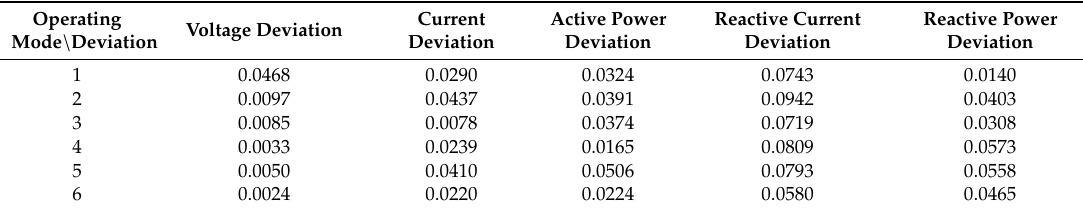
Table 5. Weighted mean deviation.